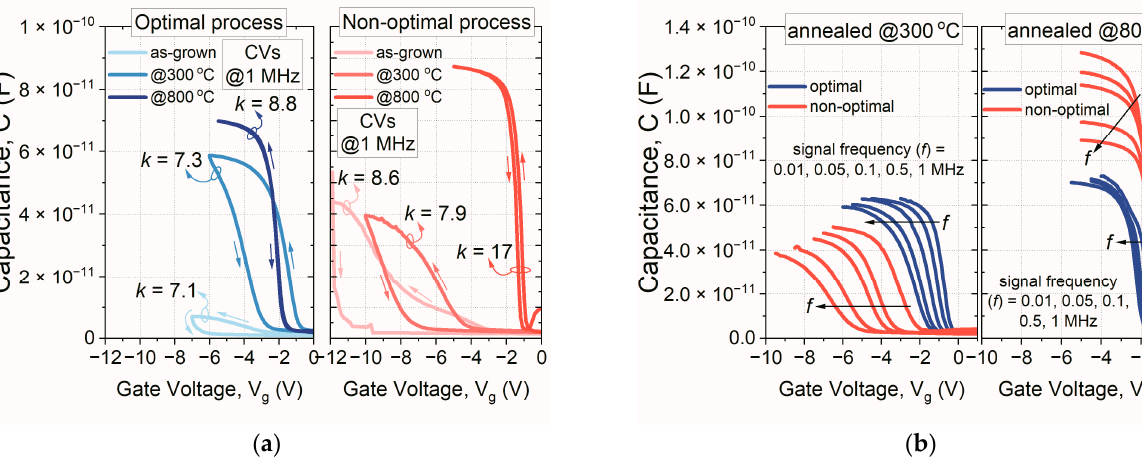
Figure 3. Comparison of the hysteresis loop ( a ) and frequency dispersion ( b ) of C-V characteristics of MOS structures with HfO x N y films, fabricated using designed sets of parameters for reactive magnetron spu tt ering processes, i.e., optimal and non-optimal processes.